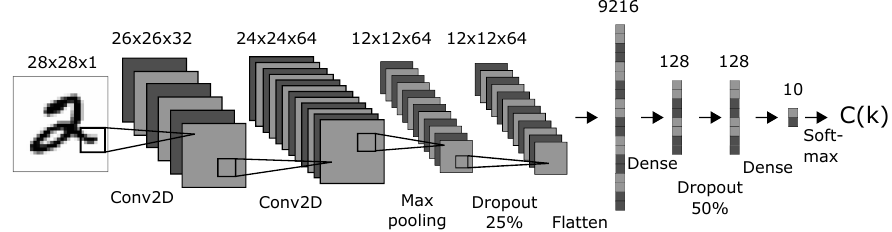
Figure 4. The topology for the CNN model. The numbers display the dimensions of the layers in the model. The abbreviations, such as Conv2D, describe the specific transformations performed between layers in the model. The activation function for the classification layer was “softmax”, and for the other layers it was “ReLU”. The optimizer used was “Adadelta”